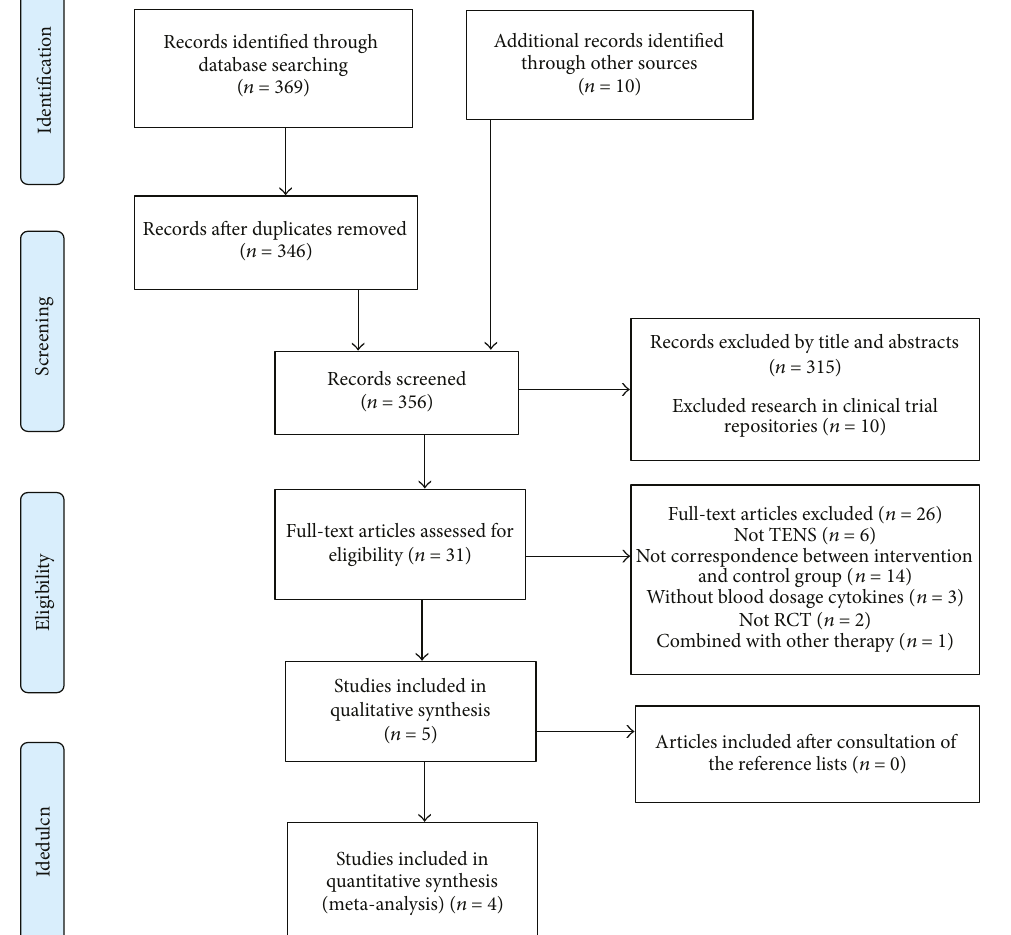
Figure 1: Search process results according to the PRISMA fl ow